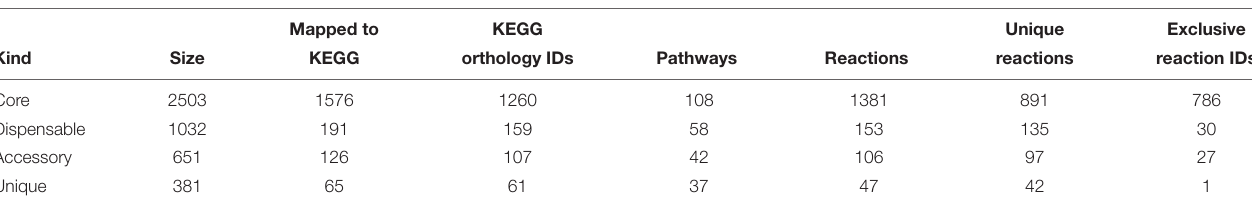
TABLE 6 | Genome analysis 1